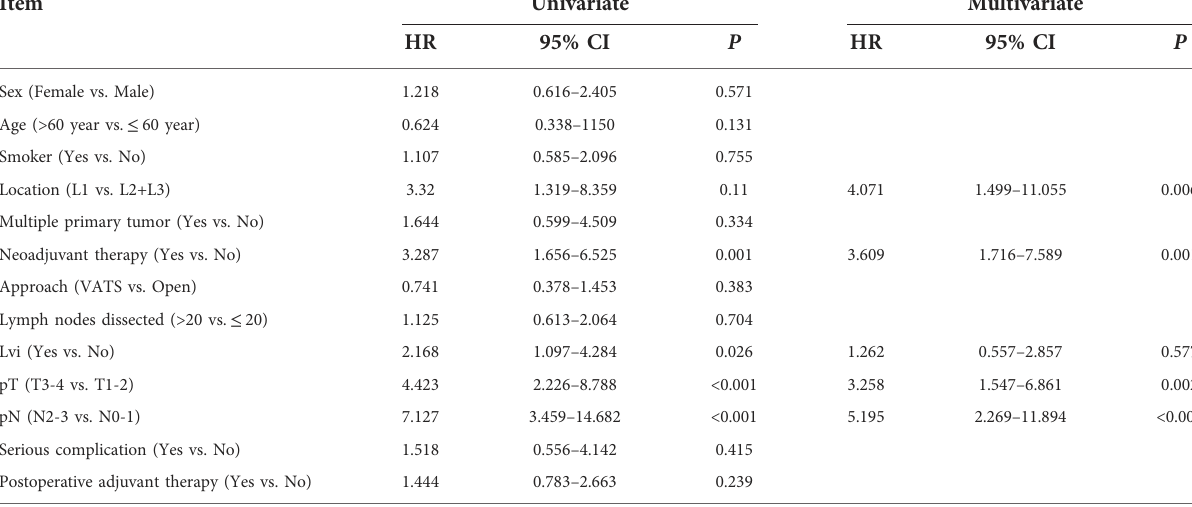
TABLE 2 Results of univariate and multivariate analyses of risk factors for PELLNR in ESCC patients with radical